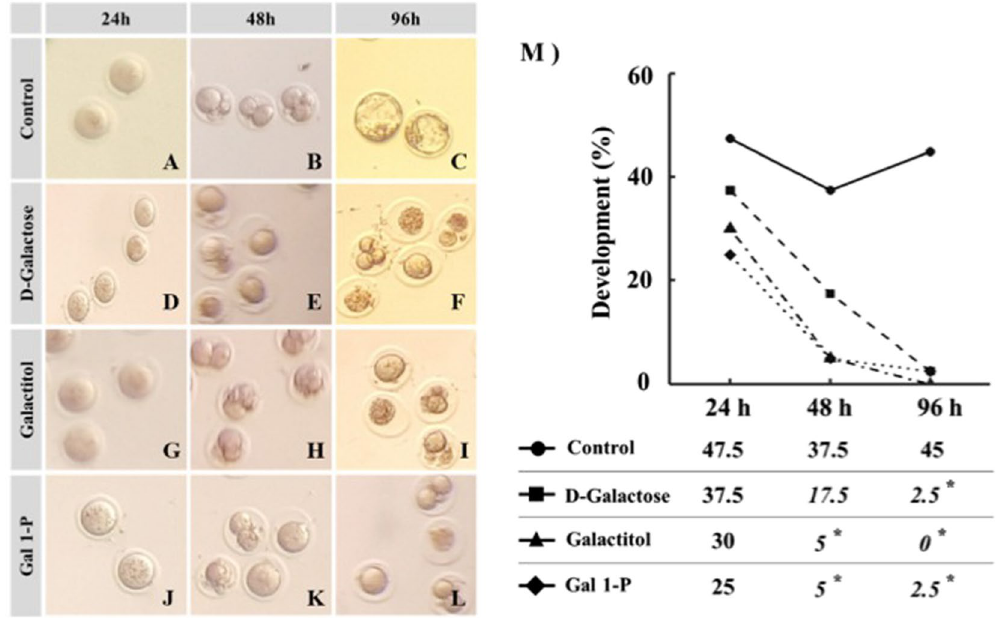
Figure 5. The effect of galactose and its metabolites on developmental competence of embryos generated by in- vitro fertilization. Images ( A – L ) represent images of embryo morphology at 24 hours (2-cell stage), 48 hours (8 cell stage) and 96 hours (blastocyst stage) after exposure to D-galactose (Images D – F ), galactitol (Images G – I ), and Gal 1-P (galactose 1-phosphate) (Images J – L ), and untreated control (Images A – C ). ( M ) The trends of changes in percentages of developed embryos at each stage compared to untreated